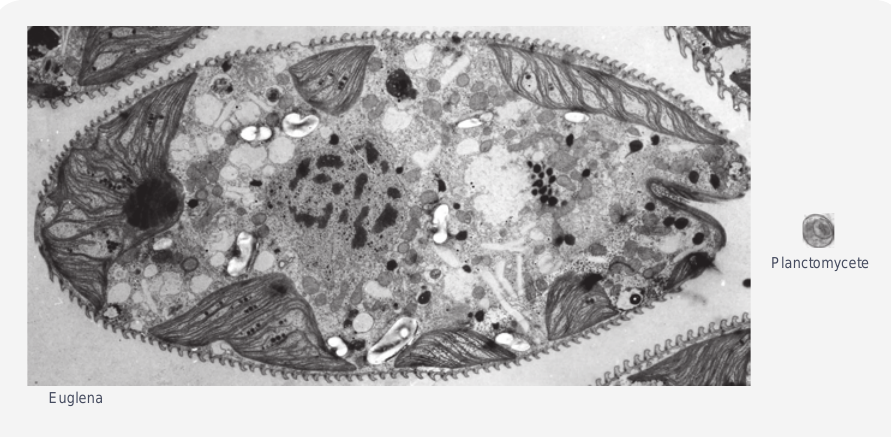
Figure 1. Difference in scale between a single-celled eukaryote (the alga Euglena) and a relatively complex bacte- rium with an intracellular compartment (planctomycetes). Roughly to scale. Photomicrograph of Euglena courtesy of M.